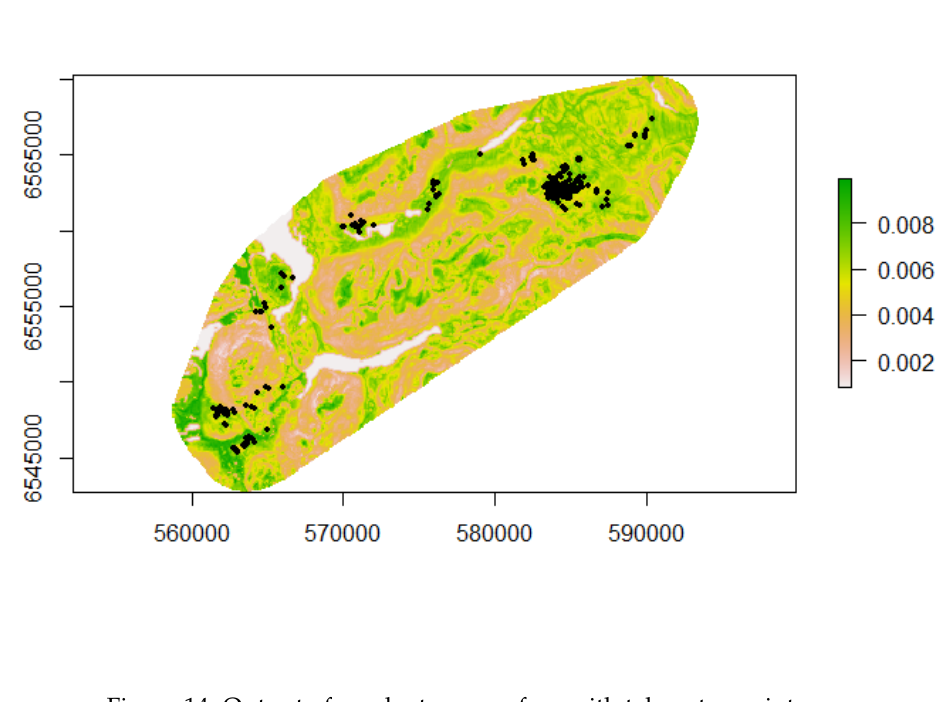
Figure 14: Output of conductance surface with telemetry